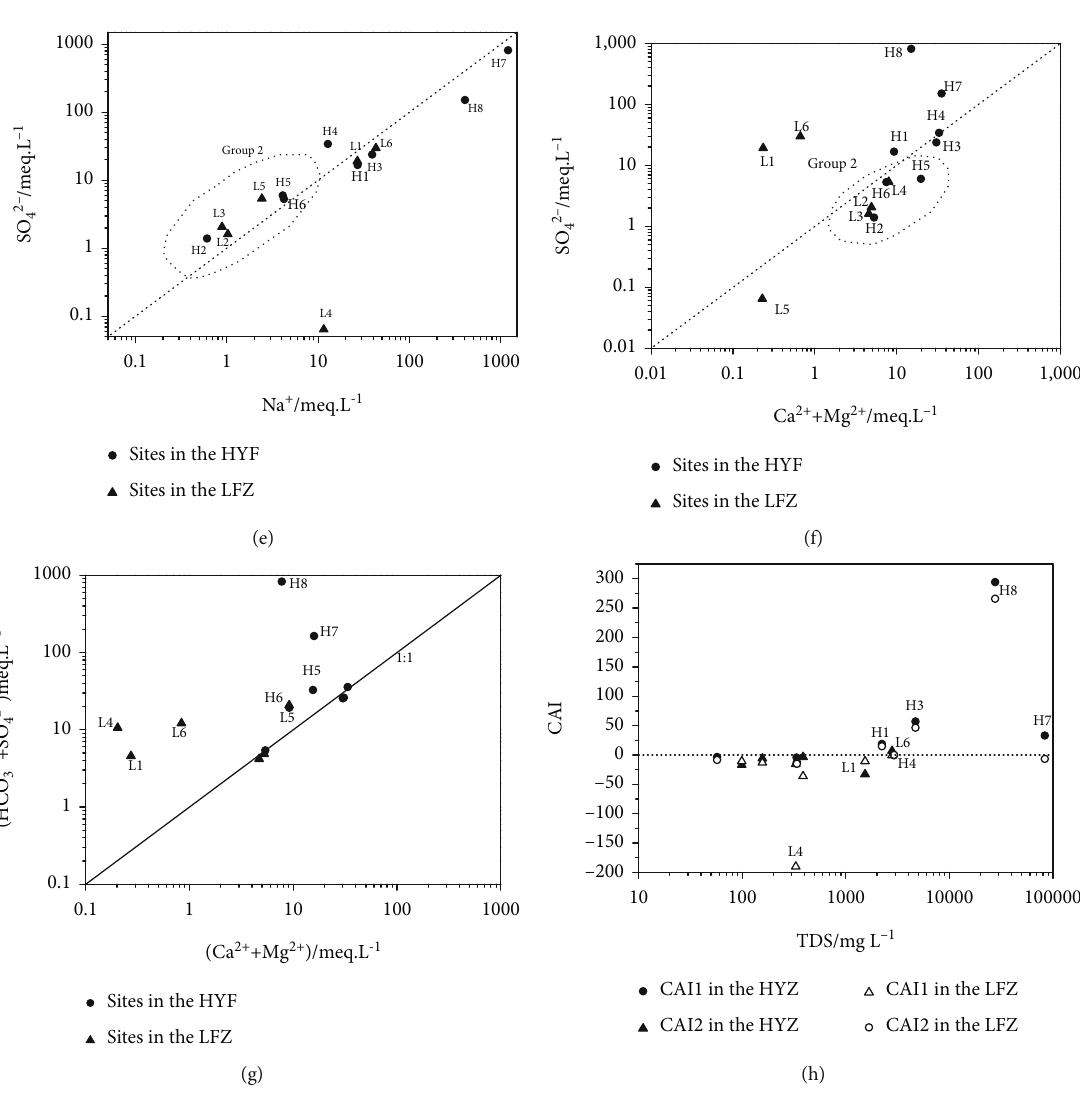
1 are near the 1 : 1 line of Na + vs. SO 42- (Figure 5(e)), but deviate from the 1 : 1 line of Na + vs. HCO